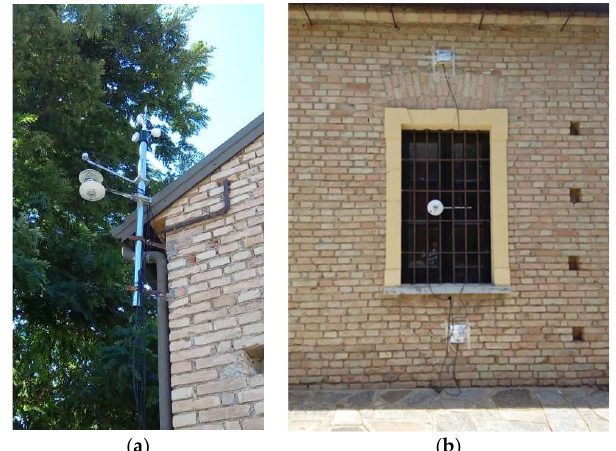
Figure 6. External climate network: ( a ) Meteorological station; ( b ) Sensors for the measurement of solar radiation and of the temperature of the external wall of the oil storage area.